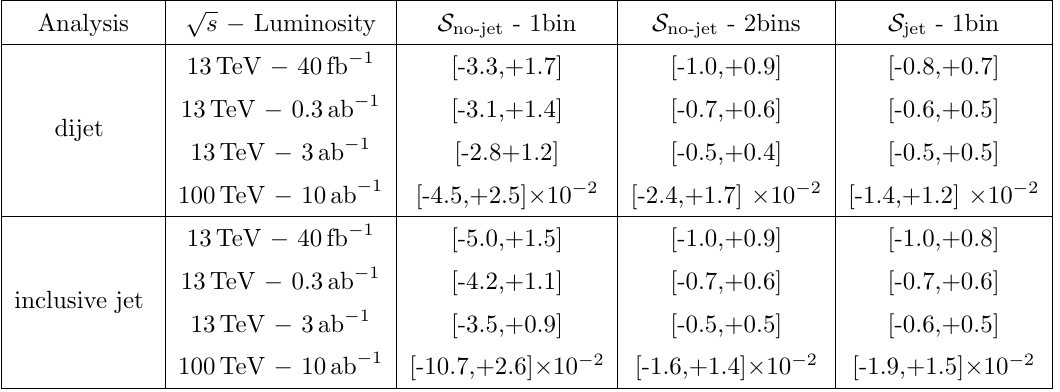
Table 8 . Projected 95% CL constraints on the Z parameter for the LHC at 13 TeV and a future p circular pp collider with s = 100 TeV.